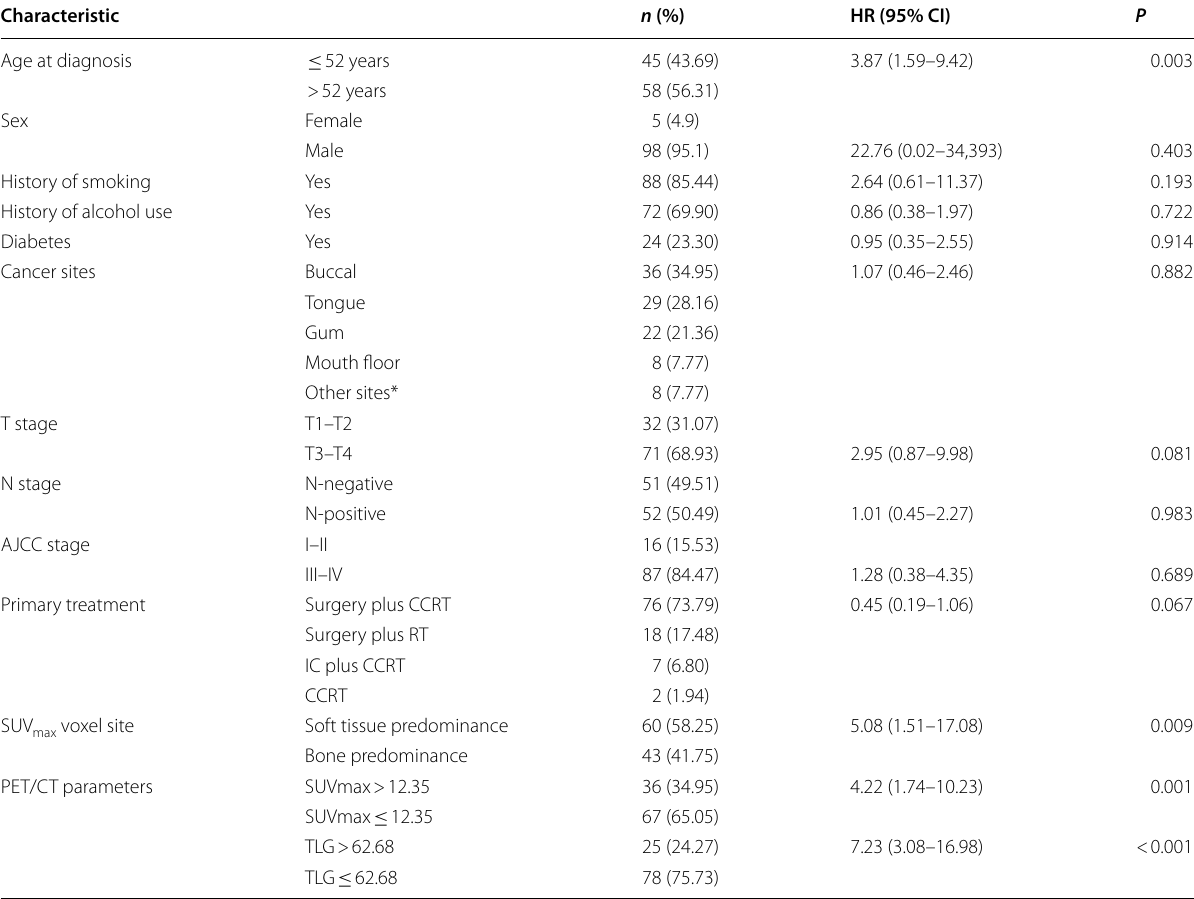
103) and univariate Cox regression analysis for mandibular relapse‑free =